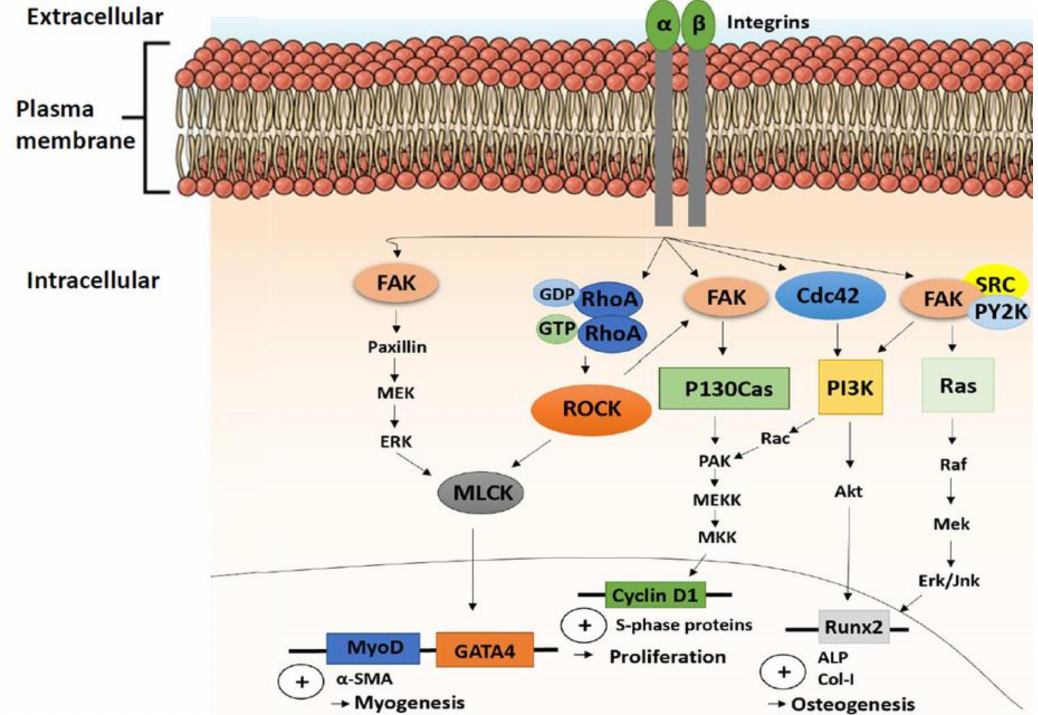
Figure 2. Sti ff ness-induced integrin-dependent focal adhesion kinase (FAK) signaling.